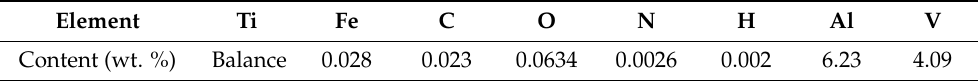
Figure 1. Powder ( a ) morphology of TiAl alloy; ( b ) particle size distribution of TiAl alloy. Table 1. Chemical composition of Ti-6Al-4V powder used in the experiments.